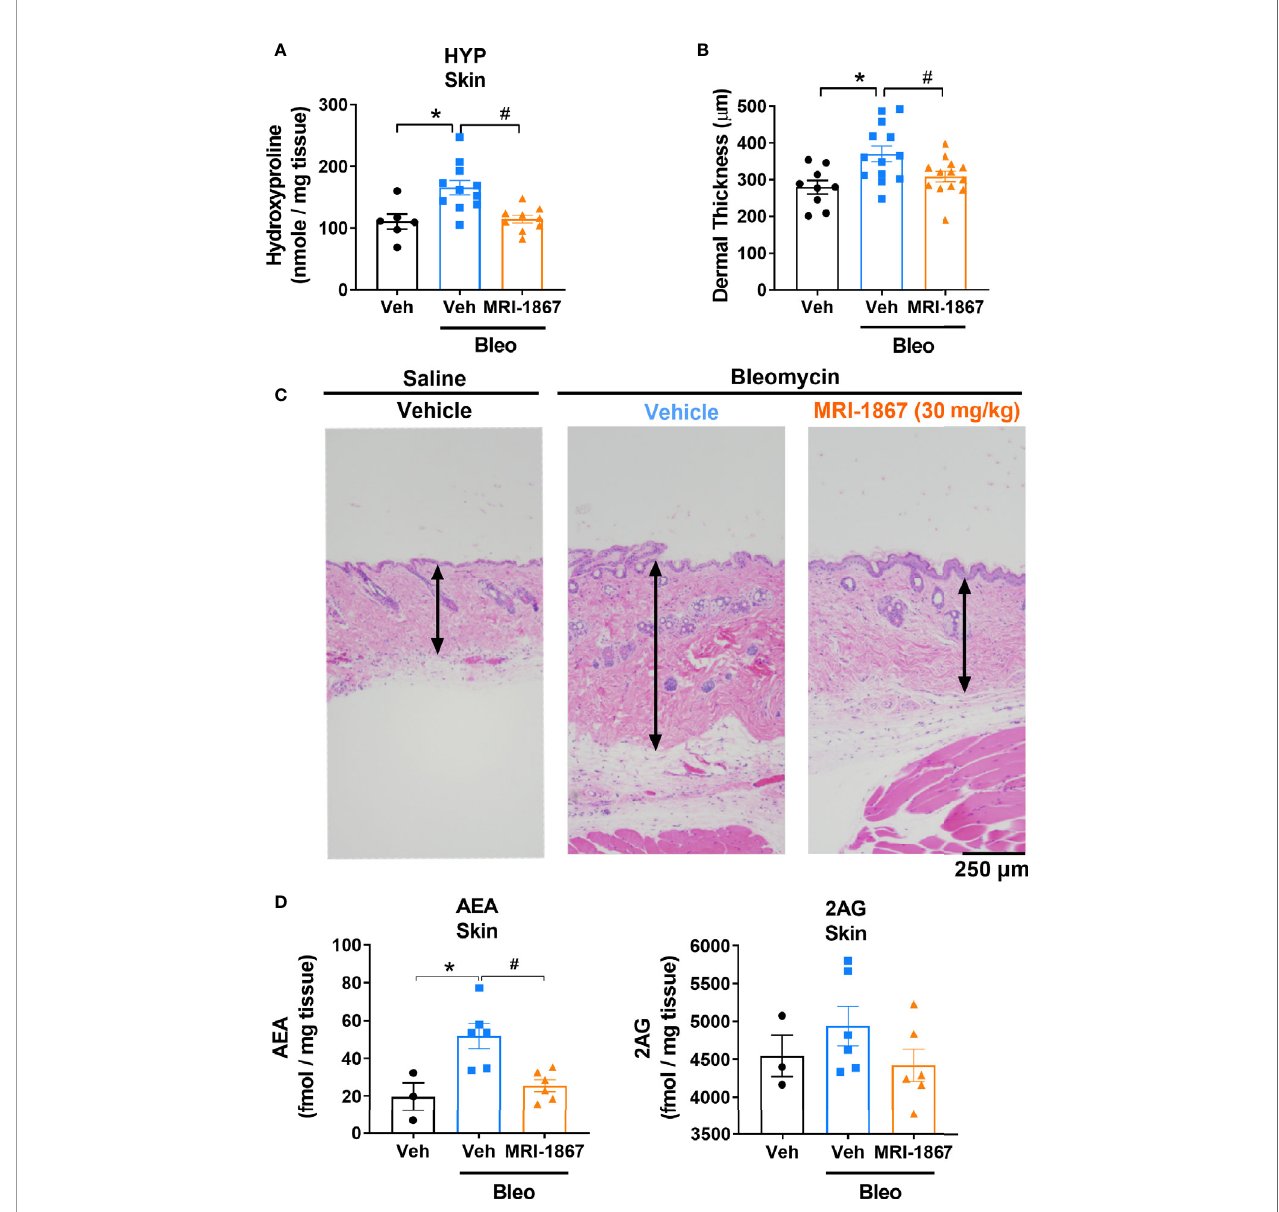
FIGURE 4 | MRI-1867 (30 mg/kg) attenuates bleomycin-induced fi brosis and dermal thickness in Mdr1 ( − = − ) -Bcrp (-/-) mice. (A) Hydroxyproline levels in biopsied skin. a = b (B) Dermal thickness analyses from skin biopsies. (C) Representative histological images from skin biopsies stained with H&E. (D) AEA and 2AG levels in biopsied skin. Six mm skin biopsies are used for the analysis. Dermal thickness assessed from left scapular injection site biopsies, Hydroxyproline and endocannabinoid measurements performed using right scapular injection site biopsies from each mouse. Data represent means ± SEM from 3-13 mice per group. Data were analyzed by 1-way ANOVA followed by Dunnett ’ s multiple comparisons test. Signi fi cant difference from corresponding values in control (saline and vehicle treated group) (*P < 0.05) or from values in bleomycin and vehicle-treated group ( # P <